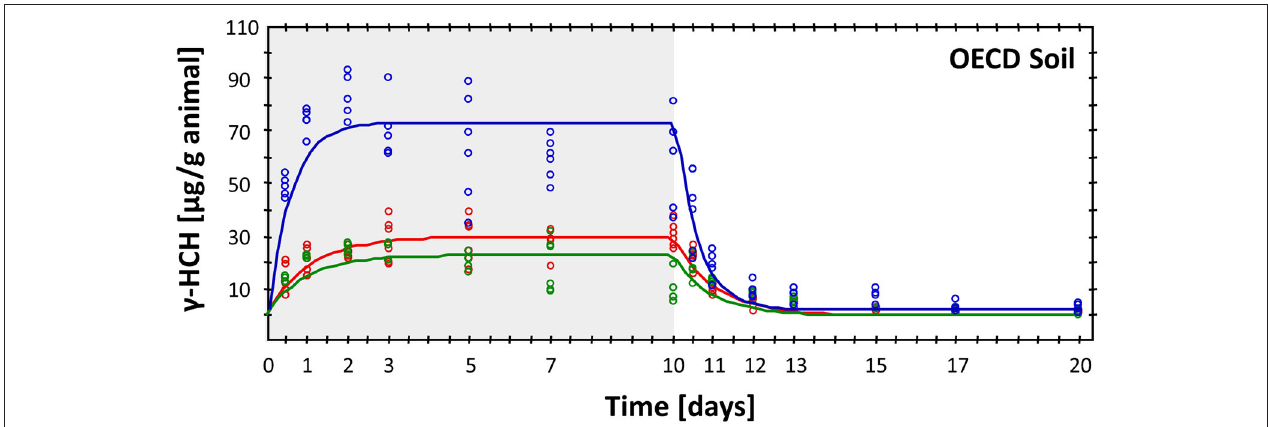
FIGURE 2 | Result of a bioaccumulation test of the insecticide lindane in Enchytraeus crypticus in OECD soil, showing both uptake (gray-shaded) and elimination phase (for details see de Amorim et al., 2002). Blue line, after freshly spiking; red line, 1 month after spiking and green line: two months after